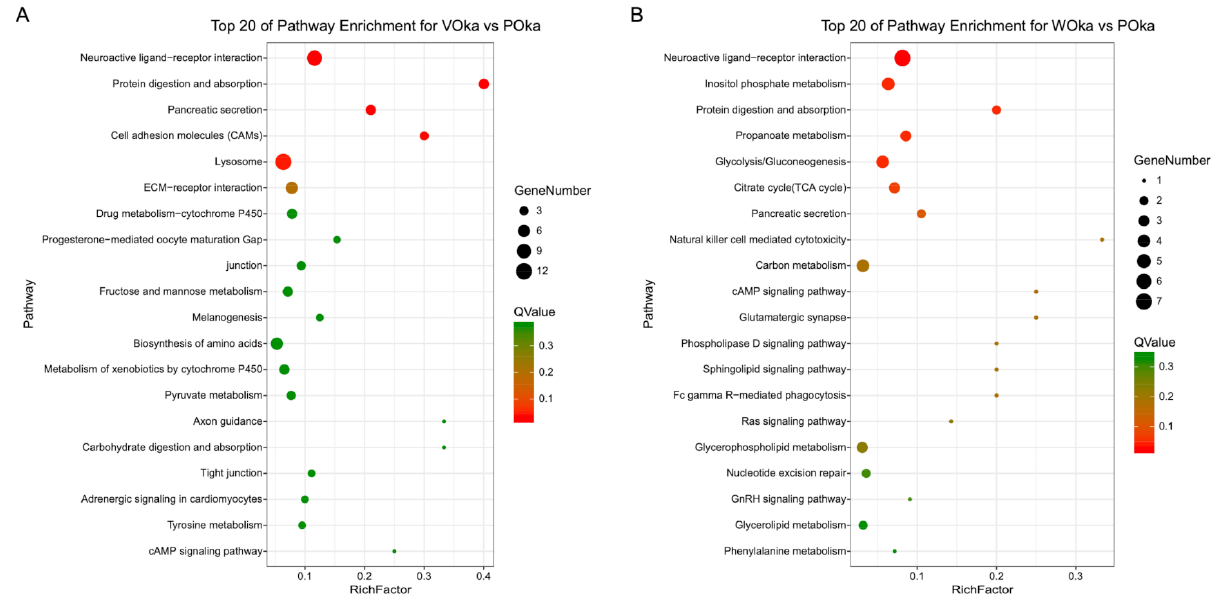
Figure 4. The top 20 KEGG pathways enriched in shrimp lymphoid organ after V. parahaemolyticus ( A ) and WSSV ( B ) challenges. Enrichment analysis of KEGG pathways was performed using the KEGG Automatic Annotation Server [23]. “Rich factor” represents the ratio of the DEG number to the number of all genes annotated in this pathway. The Rich factor is proportional to the degree of